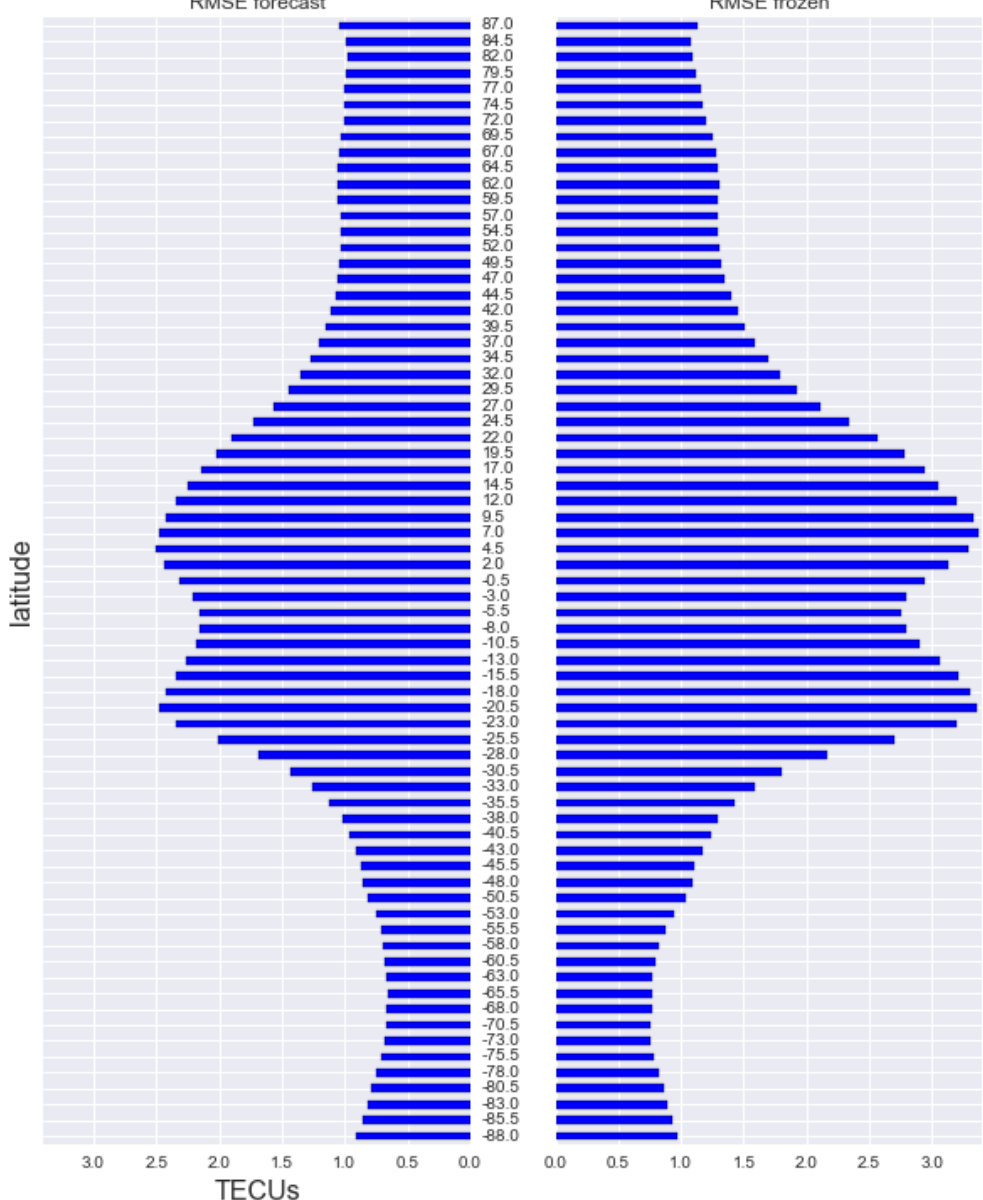
Figure 14. RMSE of tangent space method ( left ) vs. RMSE of frozen map method ( right ) as a function of the